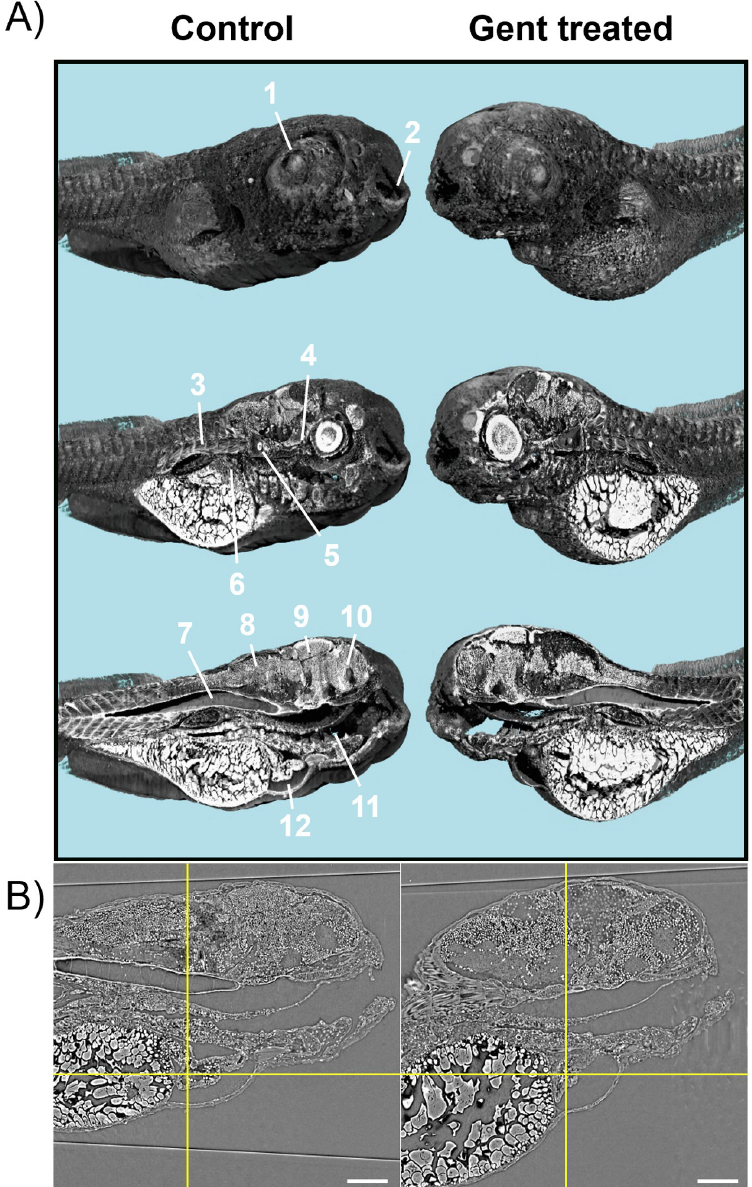
Fig 3. Synchrotron radiation-based computed tomography (SR μ CT) of control and gentamicin-treated ZFL. (A) 3D renderings of 96 hpf ZFL at 24 hpi of 1 nL of control buffer (left panels) or 1 nL of 42 mM gentamicin (right panels) with sagittal cuts. Pixel size: 0.65 μ m. Anatomical structures: 1 = eye lens, 2 = mouth, 3 = muscle tissues, 4 = optical nerve, 5 = otoliths, 6 = liver, 7 = notochord, 8 = hindbrain, 9 = midbrain, 10 = frontbrain, 11 = intestine, 12 = heart. (B) Representative virtual slices through the heart chambers (yellow reticle) of control (left) and 1 nL of 42 mM gentamicin (right) treated ZFL. Scale bar: 100 μ m. such as cell nuclei (white), cell membranes (dark grey) and cytosols (black). Comparing renal tubules of the gentamicin treated with control ZFL, a clear enlargement of the tubular lumina in the PT region was observed. To quantify aberrations in the morphology of proximal tubules of gentamicin-treated ZFL, renal tubules were manually segmented in two dimensions (XY and YZ), and diameters along